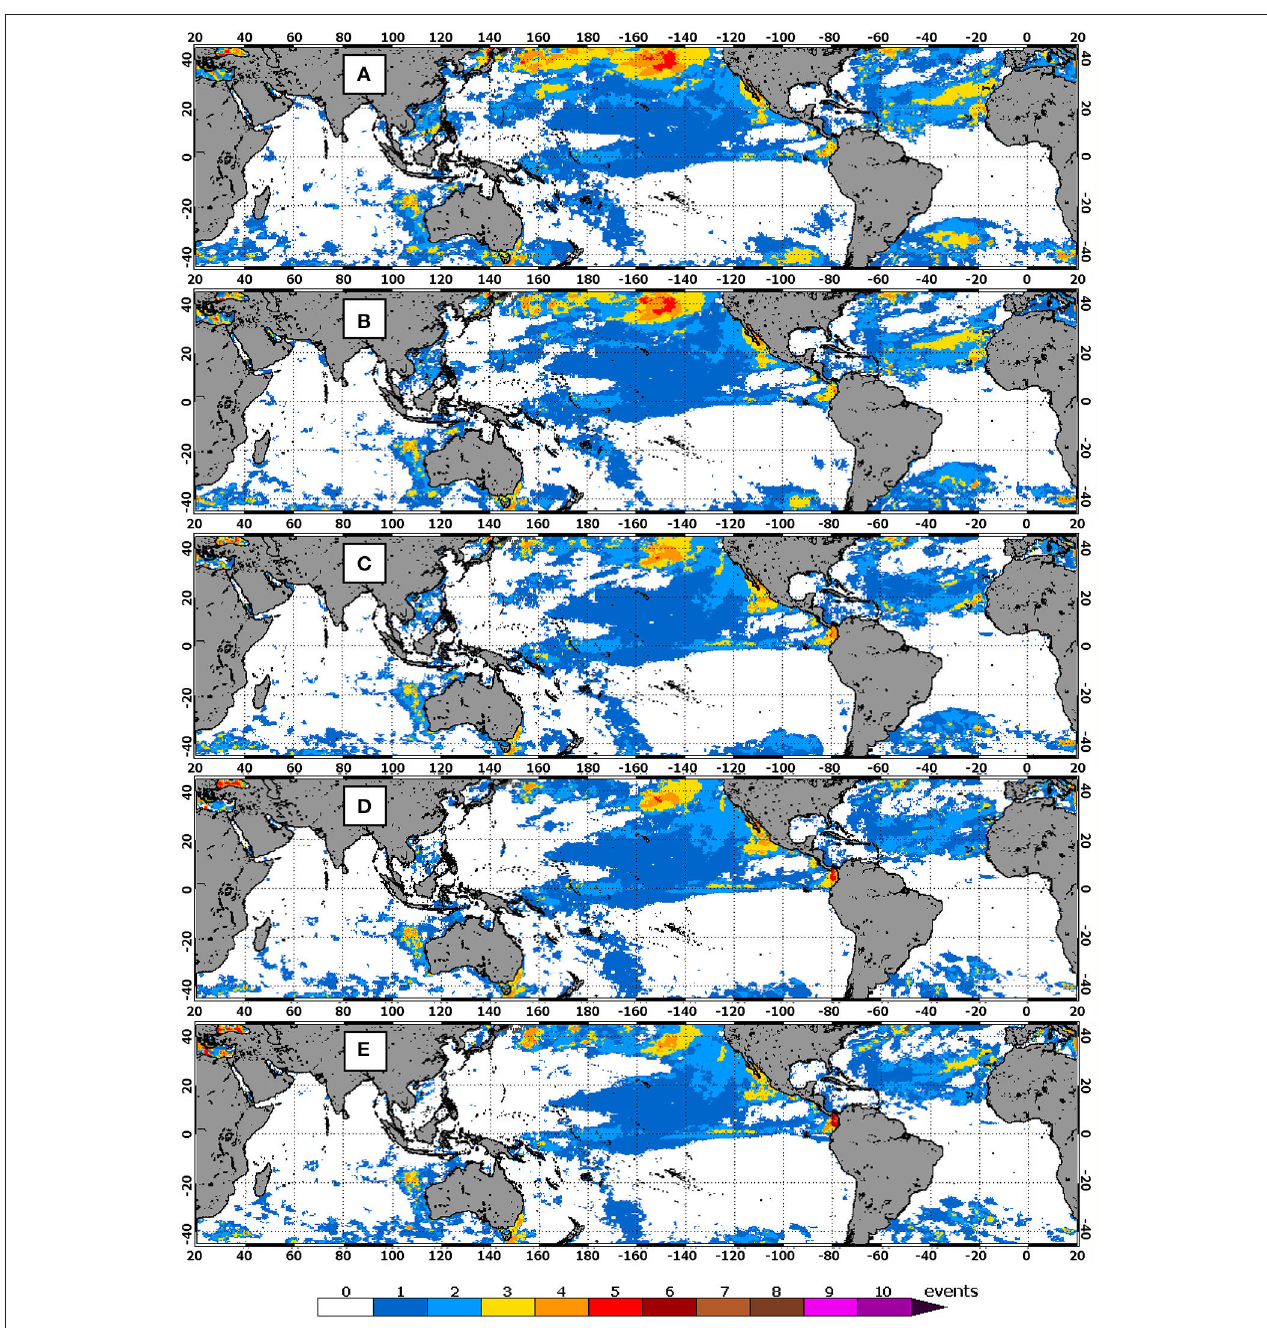
FIGURE 6 | Numbers of hits by CRW’s weekly Outlooks (Version 3) of 60% probability during the comparison time period of August 1, 2011–December 27, 2015 for lead-times of: (A) 3-weeks, (B) 5-weeks, (C) 9-weeks, (D) 13-weeks, and (E) 17-weeks.